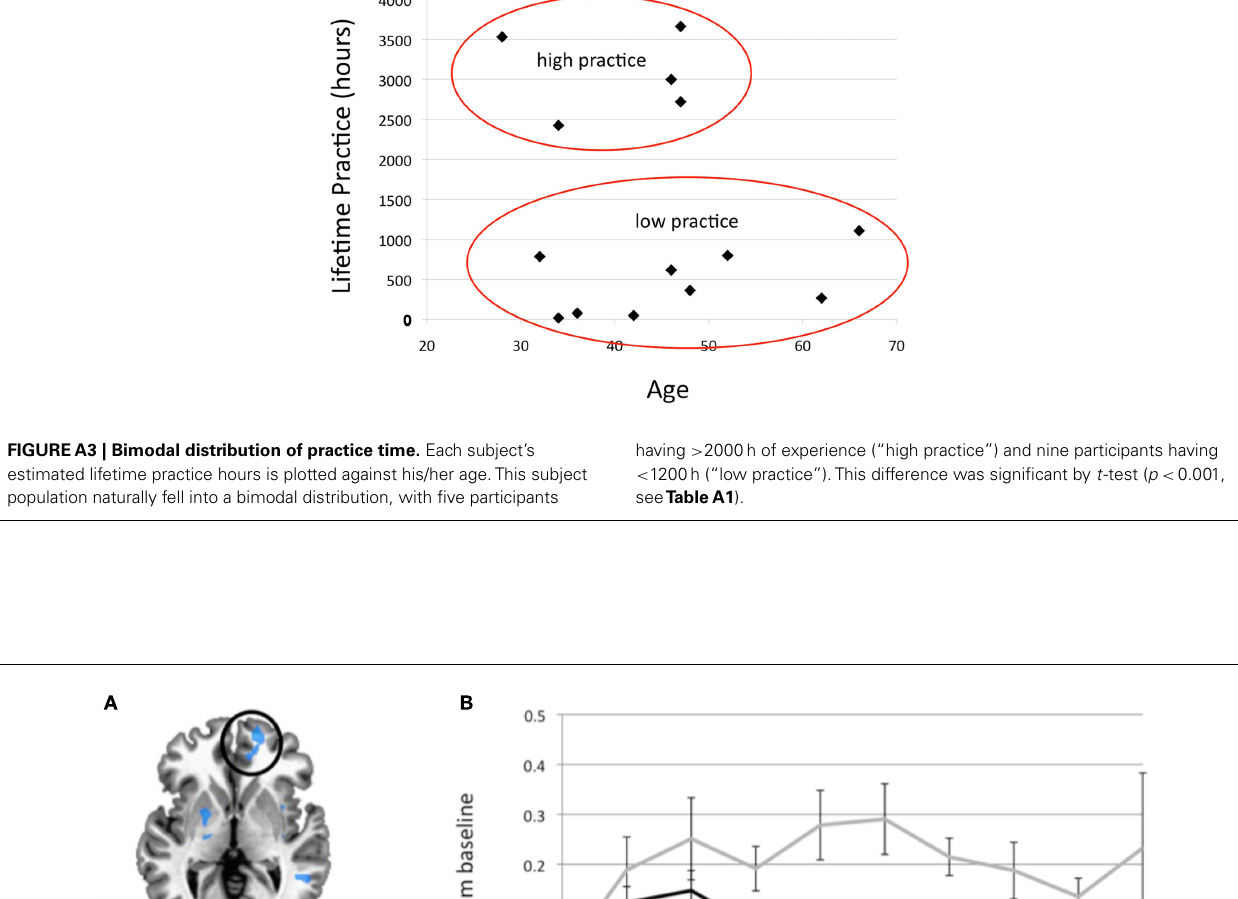
mean ± SEM) over time is plotted for high ( N = 5) and low ( N = 9) practice participants.The BOLD response is significantly reduced in high practice compared to low practice participants across the modeled time series. *Main effect of group over time by repeated-measures ANOVA, p = 0.010.This figure was adapted from a previous publication (Hasenkamp et al.,